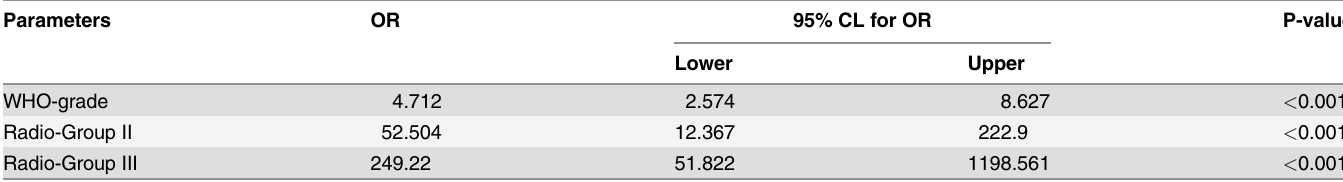
Table 4. Cox Regression analysis for the clinical and radiological parameters as predictors of